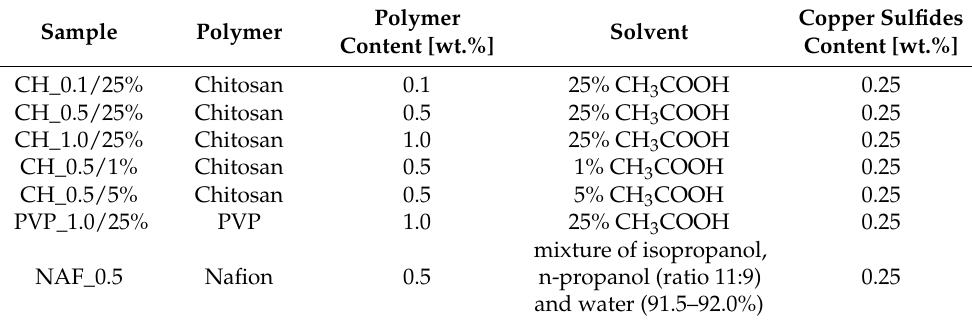
Table 1. Composition of